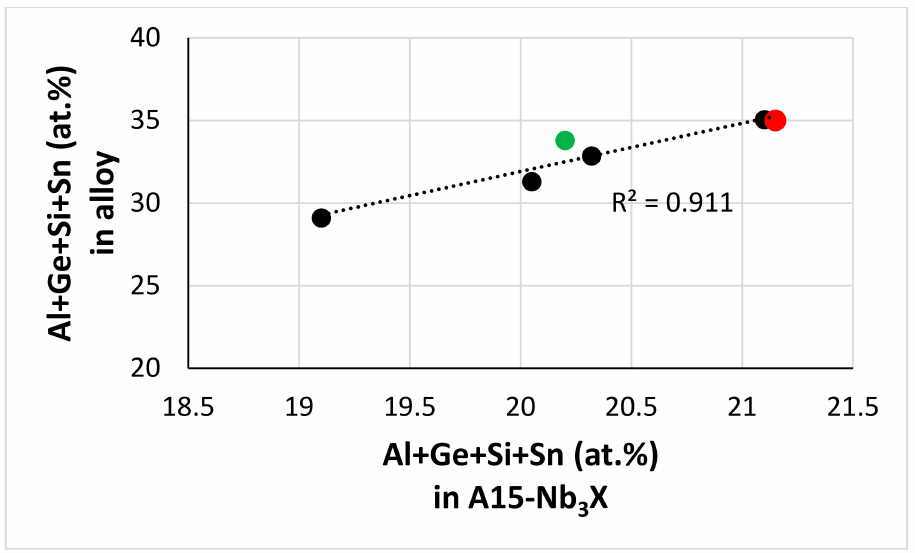
Figure 13. Relationship between the Al + Ge + Si + Sn content in alloys and A15-Nb 3 X. Data for the alloys JZ2 [46], JZ3, JZ3 + [47], JZ4 and JZ5. Red for JZ5, green for